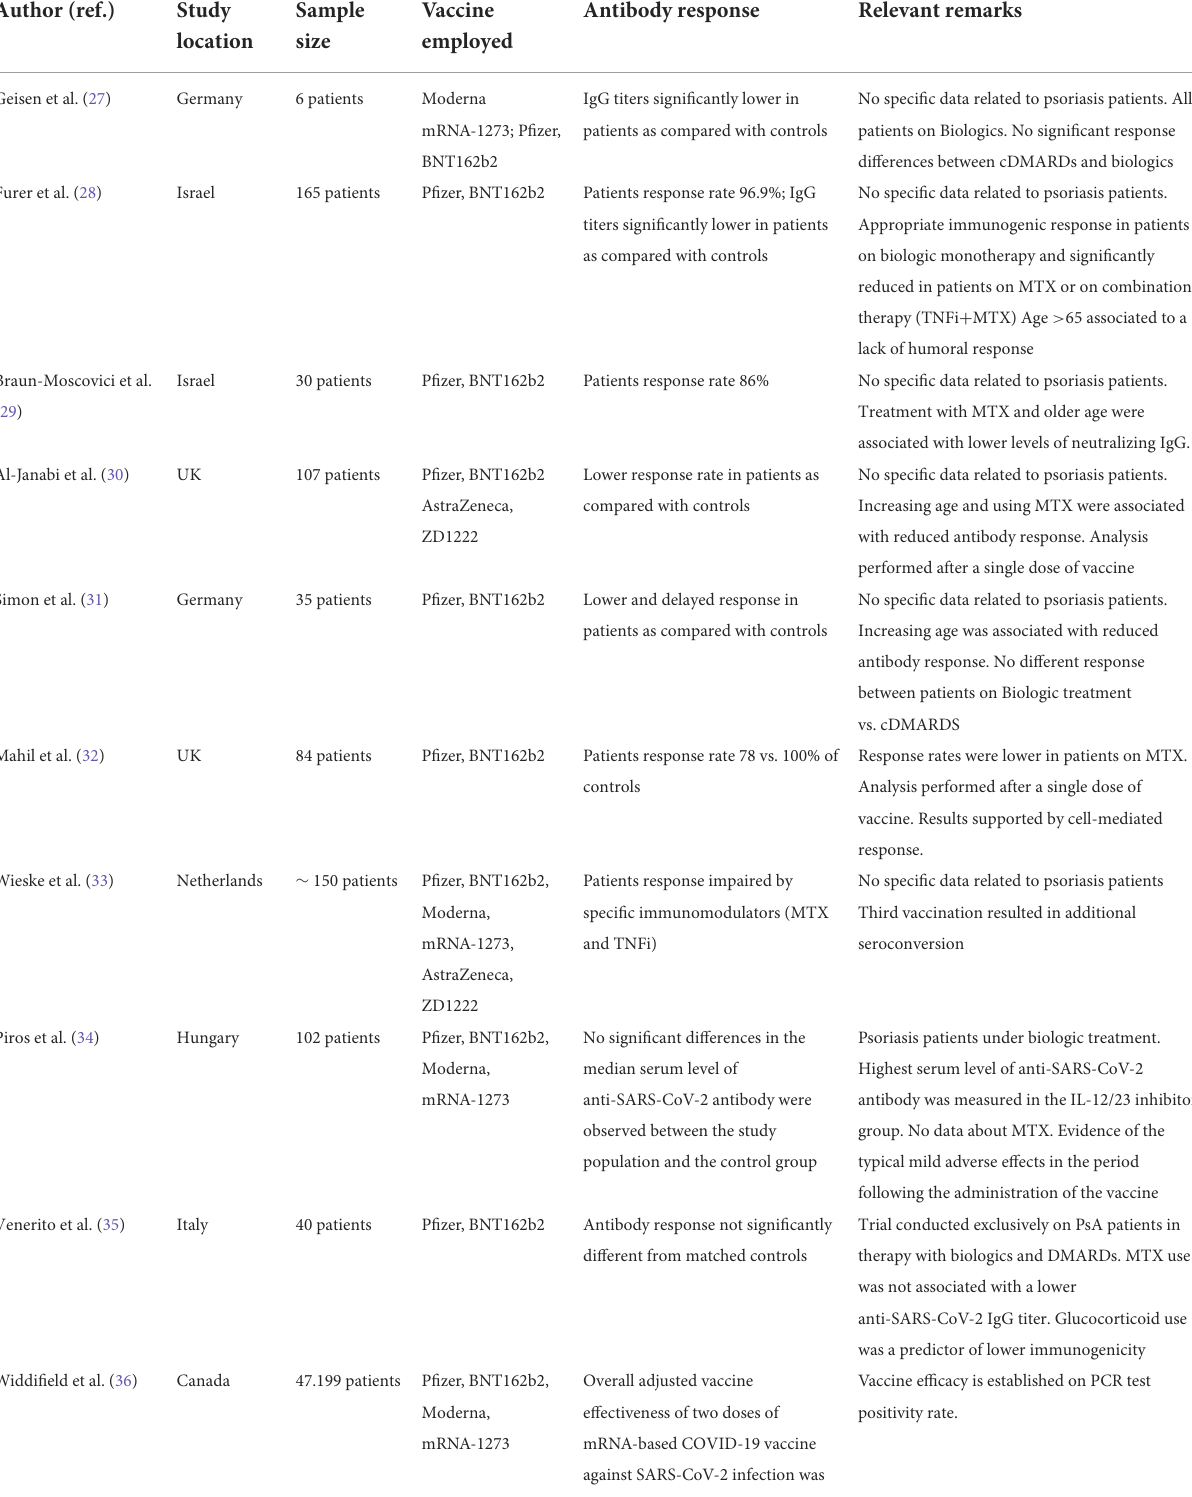
TABLE 5 Real-world data of COVID-19 vaccine response in psoriasis